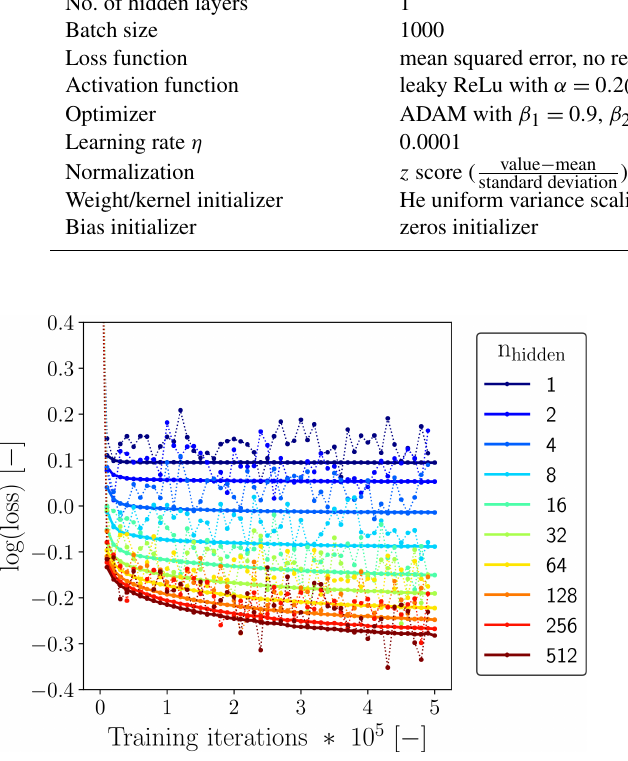
Figure 5. Evolution of the loss corresponding to the considered training batches (dotted lines) and the three validation flow fields (solid lines) with a changing number of neurons in the single hid- den layer as a function of training iteration, for the ANNs using f hor , train = 8 (see Sect. 3.5.1). To improve readability and keep the total computational effort involved in the training feasible, we show here both losses only for every 10000 iterations instead of every single